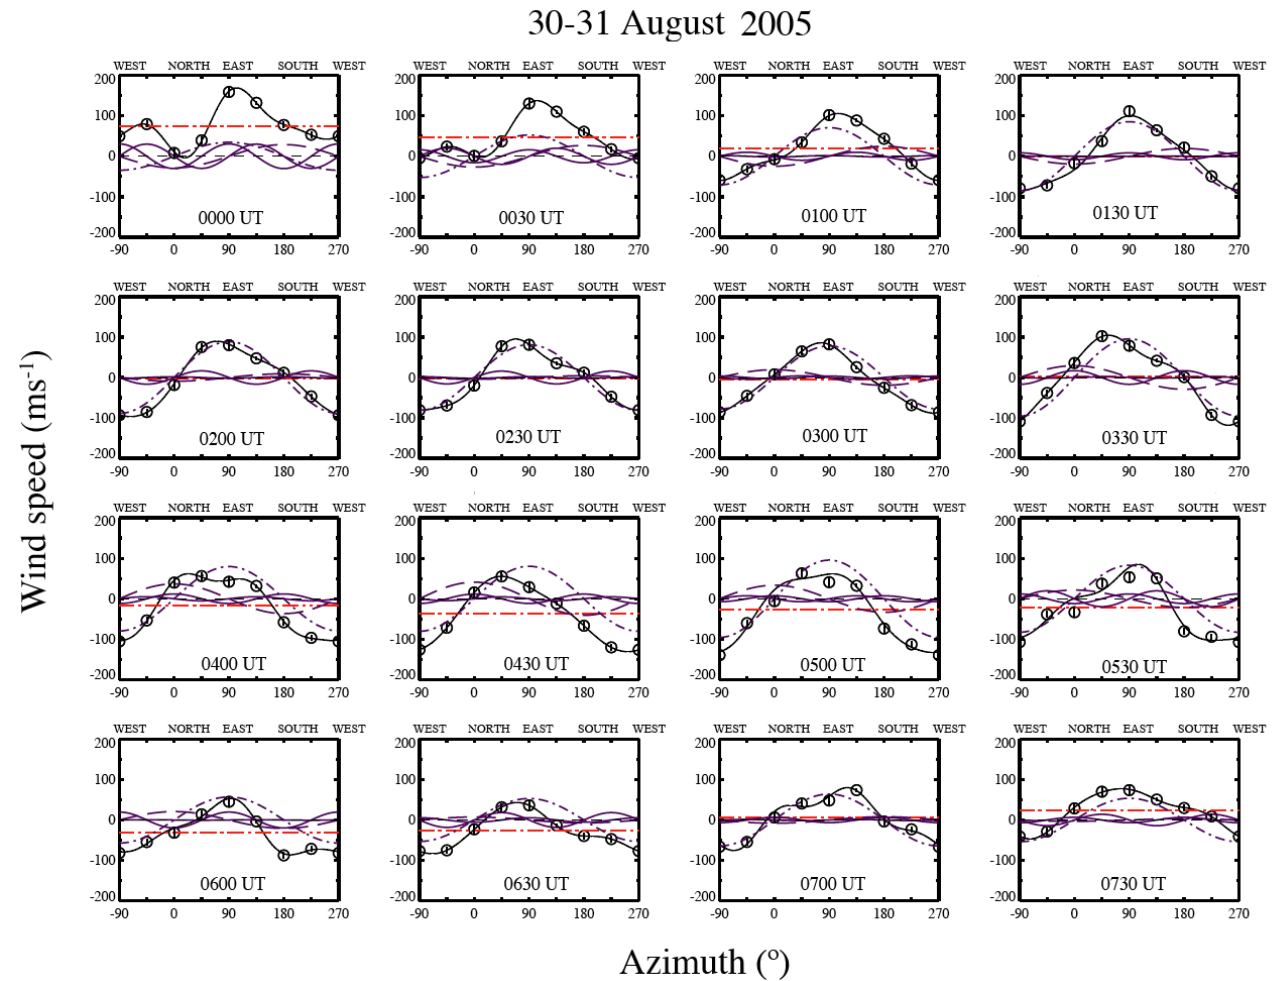
Fig. 5. Line-of-sight neutral wind speeds (round data points) observed on 30–31 August 2005, plotted against azimuth angle for 16 observing cycles from 00:00UT to 07:30UT. The vertical line within each data point indicates ± 1 σ standard deviation. Each observing cycle includes 8 azimuthal line-of-sight directions distributed between 0 ◦ and 360 ◦ at 45 ◦ intervals. The contributions from the three harmonics for the Fourier decomposition (Eq. 3) of the neutral wind field are shown as dashed (first order or second order) or solid (third order) lines. The black line is the overall fit using these three harmonics. The dotted red line is the divergence calculated from the gradients determined from this